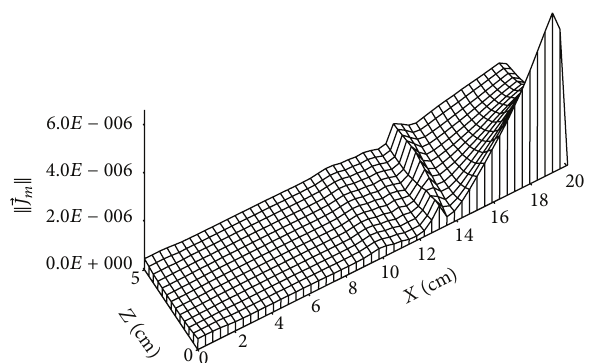
Figure 15: Distribution of total mass flow (in kg/m 2 ⋅ s) for 𝑡 = 135 days.